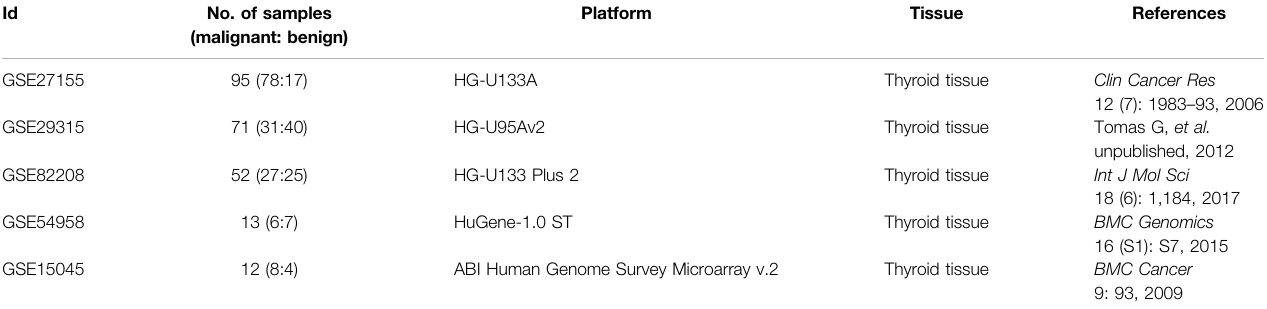
TABLE 1 | Datasets collected from fi ve independent microarray studies of thyroid nodules (sorted by sample size). Each dataset contained one cohort of malignant and another cohort of another group of benign samples. Id No. of samples (malignant: benign)